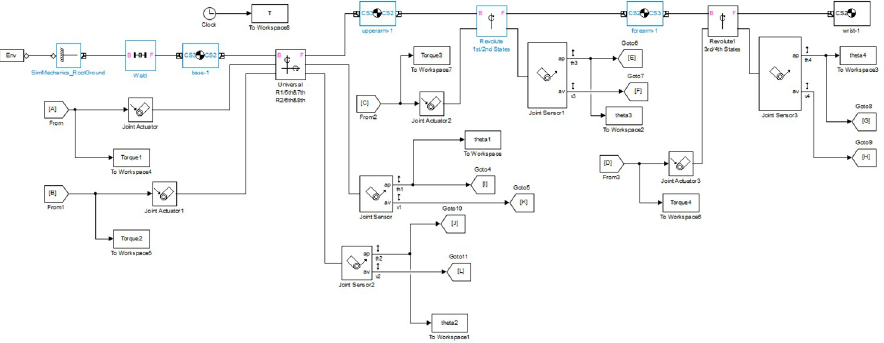
Fig 2. Simulink open-loop model of the robotic